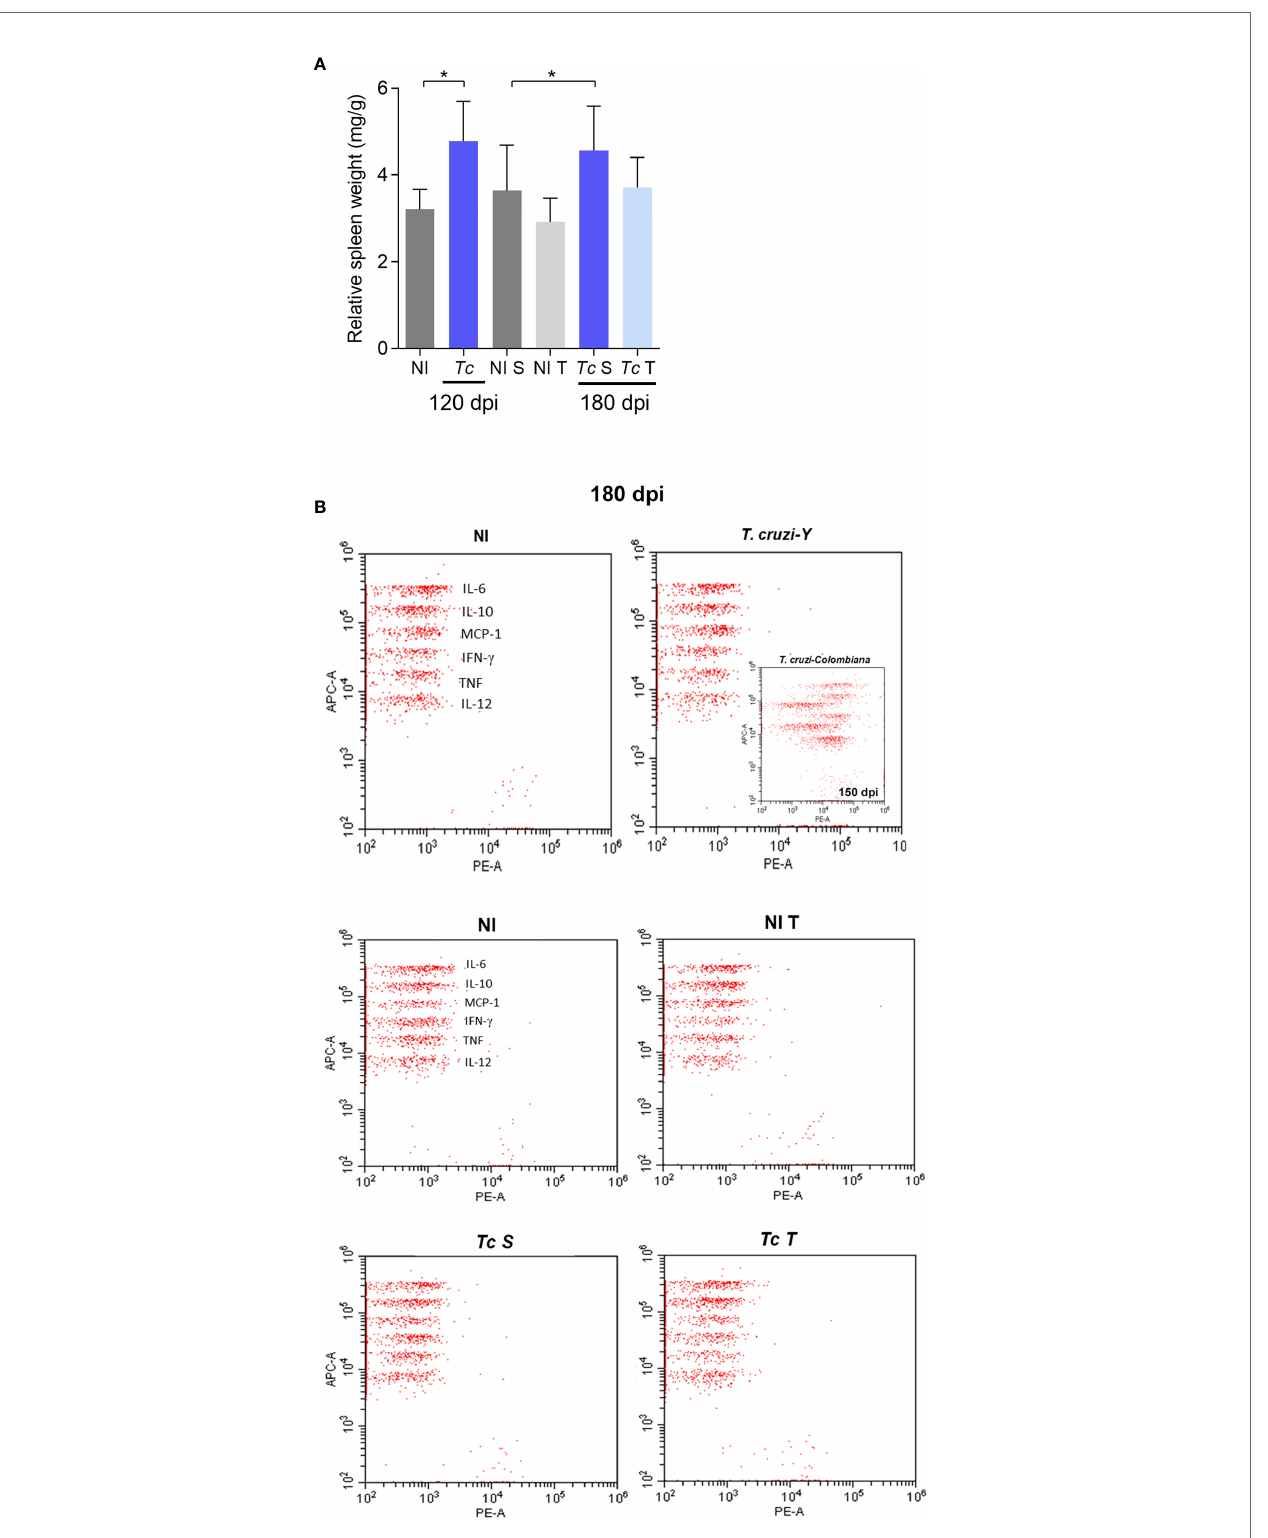
FIGURE 6 | T. cruzi infection causes mild splenomegaly but does not induce a systemic in fl ammatory pro fi le in C57BL/6 mice. (A) Relative spleen weight. (B) Representative dot plots of Y-infected C57BL/6 mice at 180 dpi and inserted dot plots of Colombian-infected C57BL/6 mice at 150 dpi. The data are represented as means ± SEM. Data represent six to eight mice per group *p < 0,05 ( Mann – Whitney; two-way ANOVA Sidak ’ s posttest; Kruskal – Wallis test , Dunn ’ s posttest